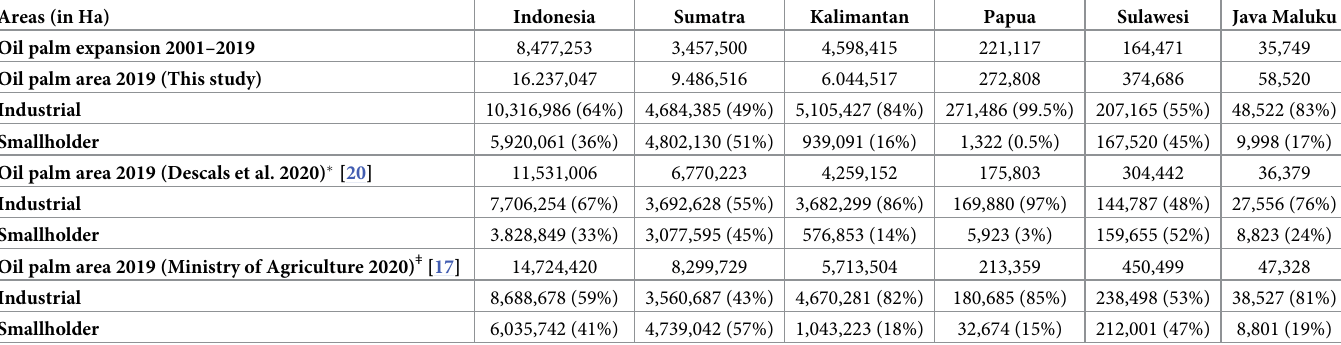
Table 2. Oil palm expansion from 2001 to 2019 and planted area in 2019 for Indonesia and by region. Based on three different sources: this study, a global study and government statistics. Areas (in